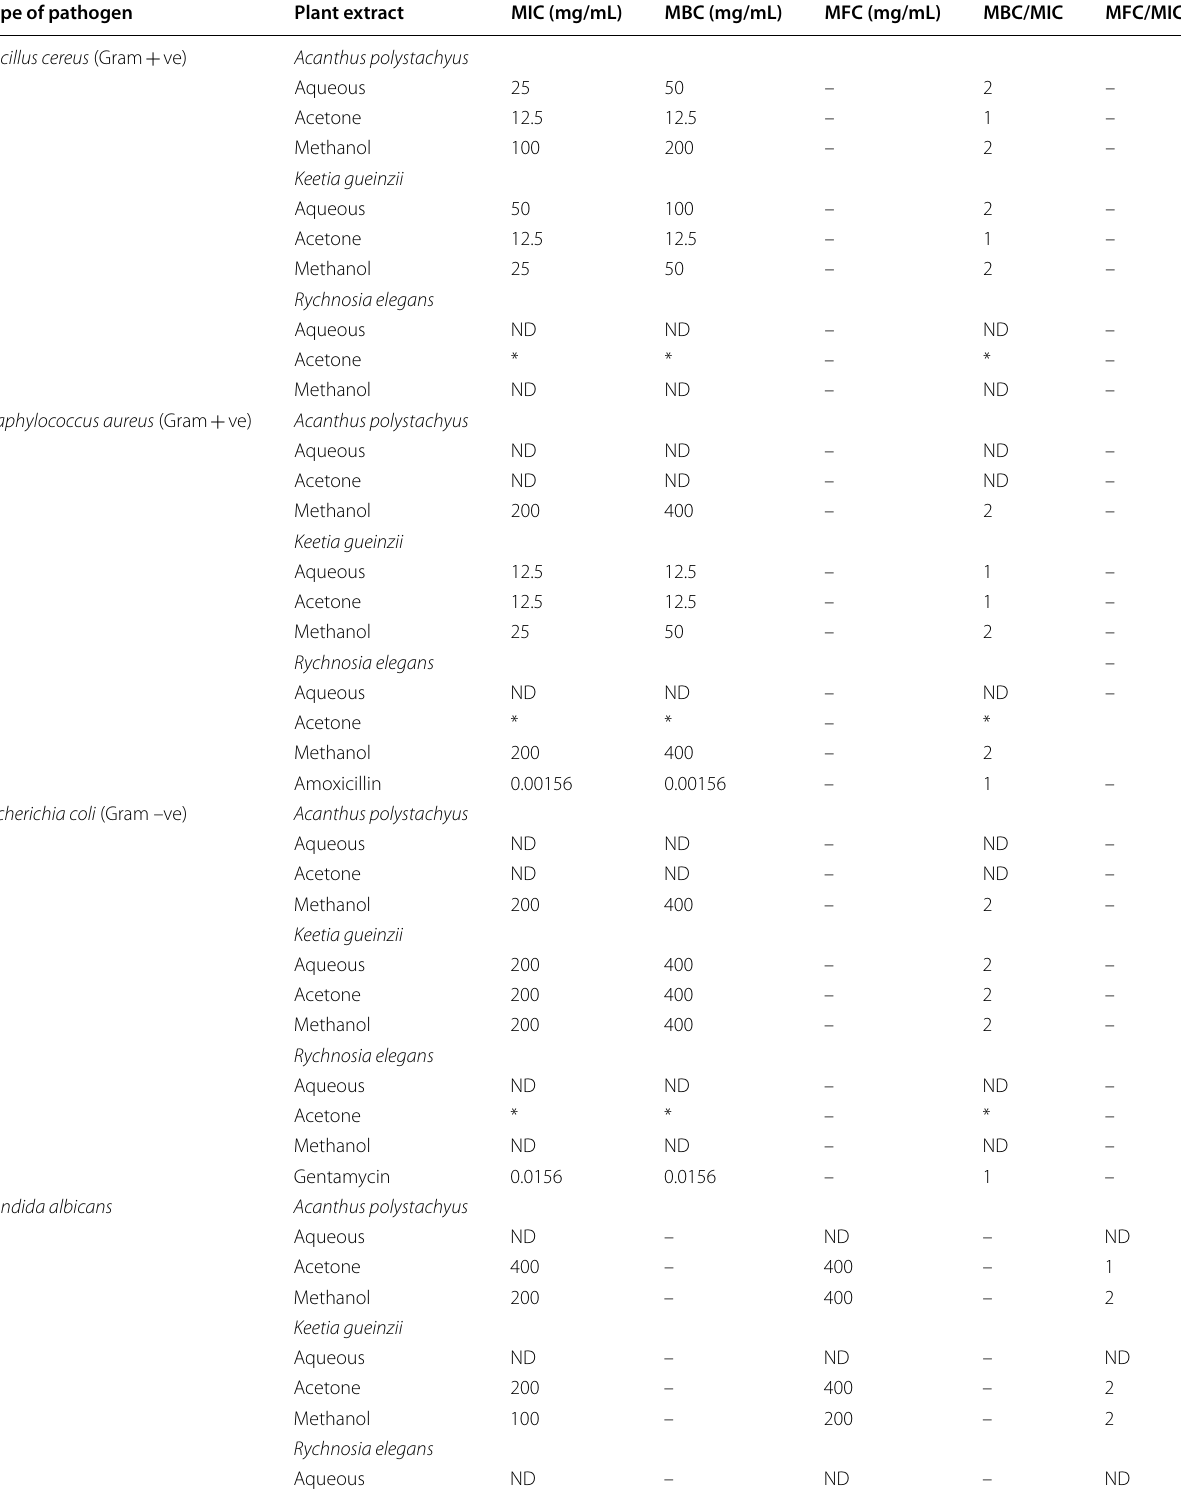
Table 3 The minimum inhibitory/bactericidal/fungicidal concentrations of crude root, root bark, and root tubr extracts of Acanthus polystachyus, Keetia gueinzii, and Rychnosia elegans respectively Type of